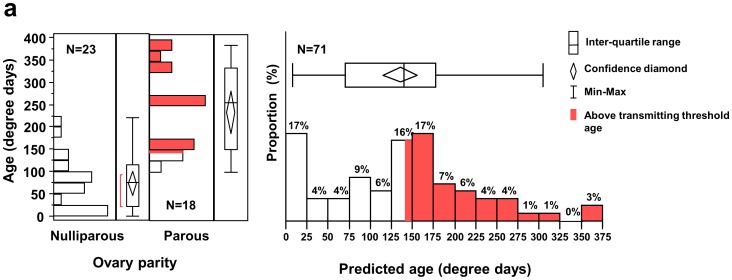
The frequency histogram and quantile plots of predicted age (in degree-days) of field- collected Anopheles gambiae mosquitoes.Mosquito age was determined based on the transcription profiles of the two molecular markers. a) Mosquitoes were collected from Mbita, Suba District, western Kenya, and were classified based on parity status mosquitoes. N means the number of mosquitoes collected and used for age predition; and b) Mosquitoes were collected from Kisian, Kisumu District, western Kenya. The red bar represents those mosquitoes that lived sufficiently long enough (>143 degree-days) to potentially transmit malaria.